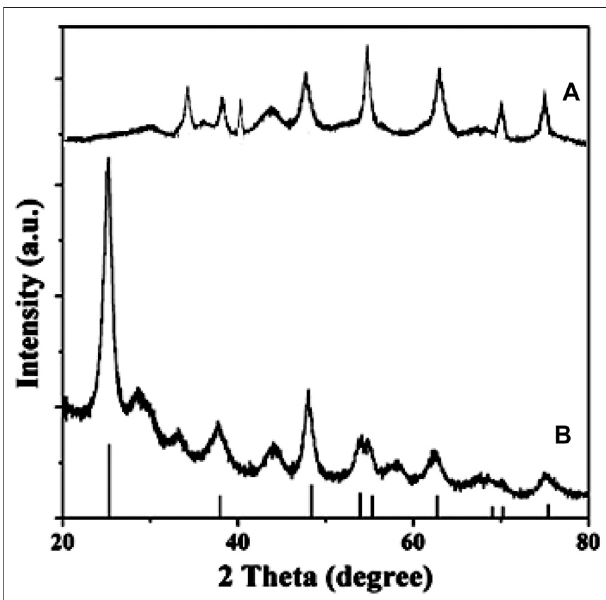
FIGURE 3 | X-ray powder diffraction pattern of the Titanium sheet (A) and porous TiO 2 microspheres (B) .